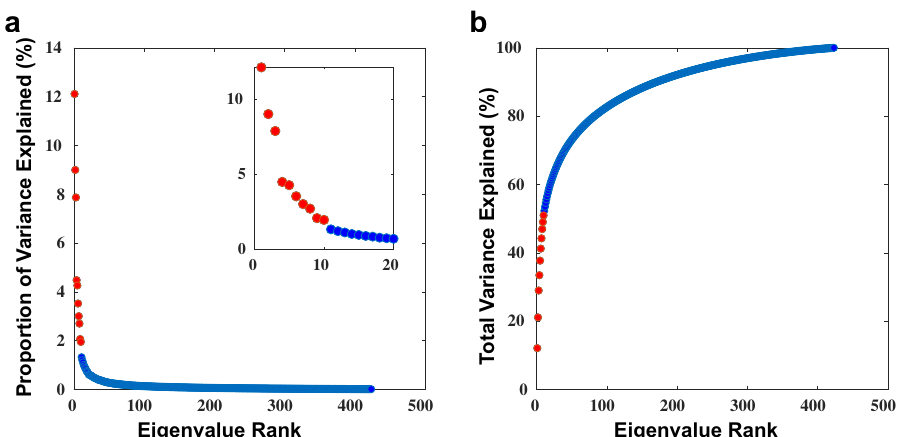
Fig. 5 Low-rank structure. a A plot of the proportion of variance explained by each eigenbrain organized in rank order. The fi rst 10 components are highlighted in red, with the remaining 413 components in blue. The same plot for the fi rst 20 components is inset highlighting the natural break after the fi rst 10 components. b A plot of the cumulative total variance explained at each rank. The majority of the variance (51%) is explained by the fi rst 10 components that are highlighted in red with the remaining 413 components in blue. Source data are provided as a Source Data fi